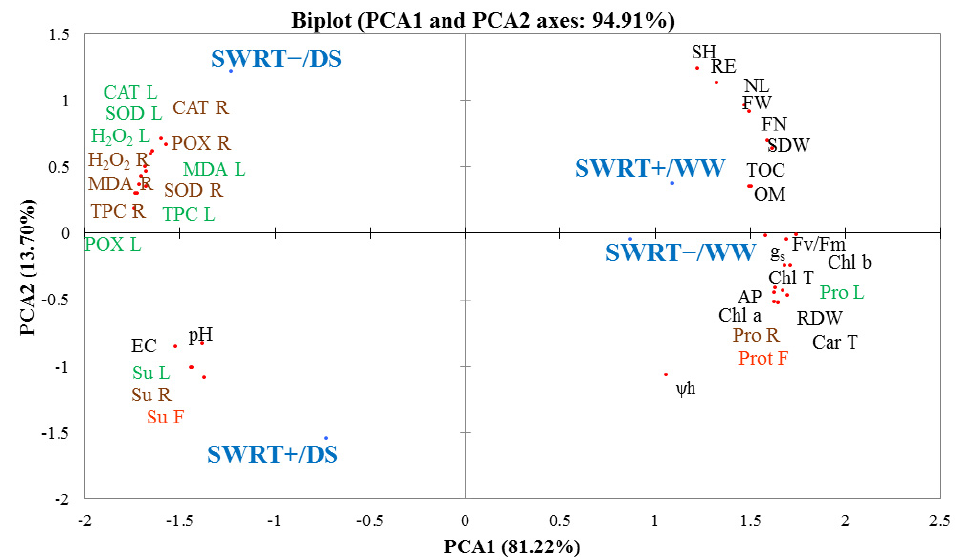
Figure 4. Principal component analysis (PCA) of tomatoes exposed to different treatments. SWRT − : without subsurface water retention technology (SWRT); SWRT+: with SWRT under two water regimes (DS: drought stress or WW: well-watered). SH: shoot height; NL: number of leaves; SDW: